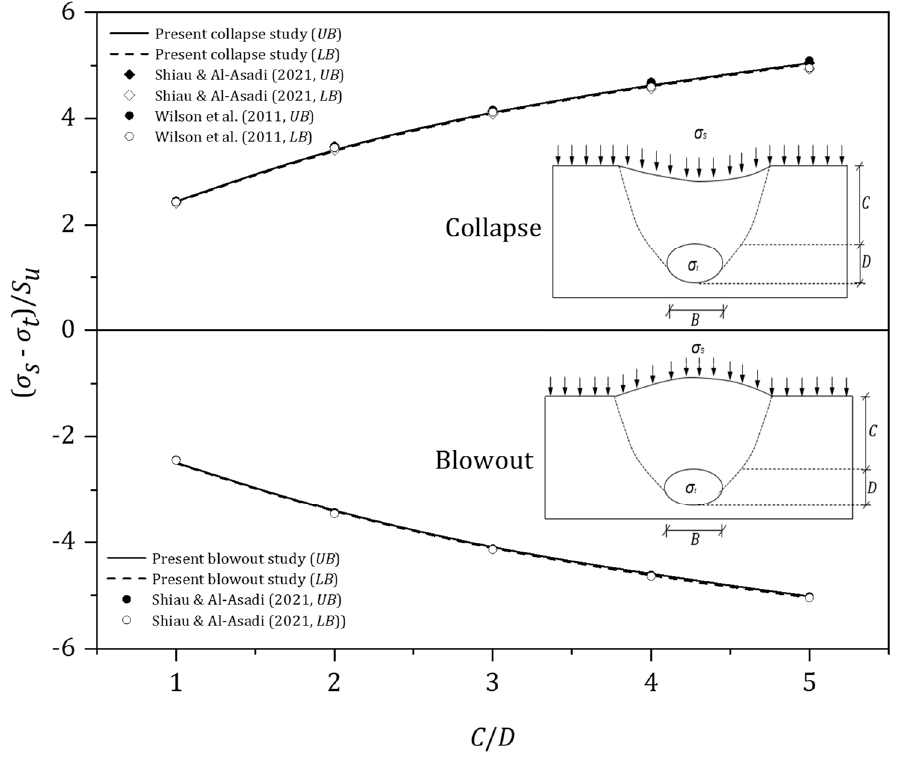
Figure 20. Comparison of